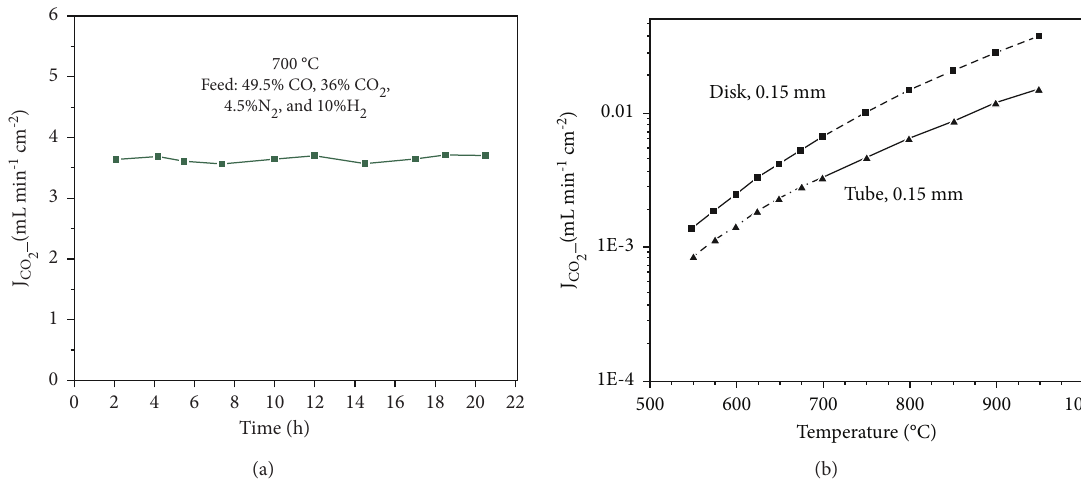
Figure 10: (a) High temperature stability test at 700 ° C for 0.12mm asymmetric tubular dual-phase membrane in simulated syngas [62]; (b) comparison of CO 2 fluxes for disk- and tube-shaped membranes as a function of temperature